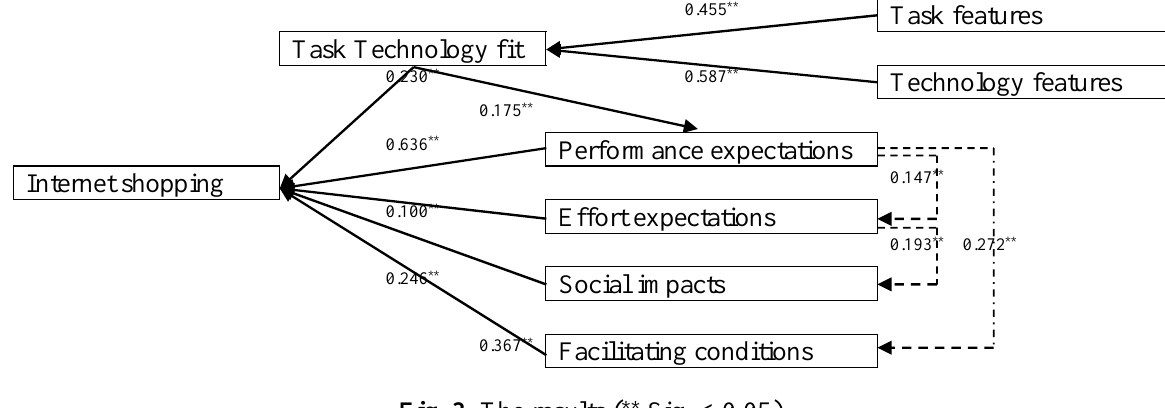
Fig. 3. The results ( ** Sig. <